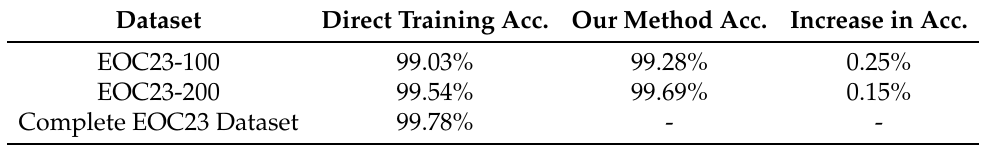
Table 8. EOC3 datasets experimental